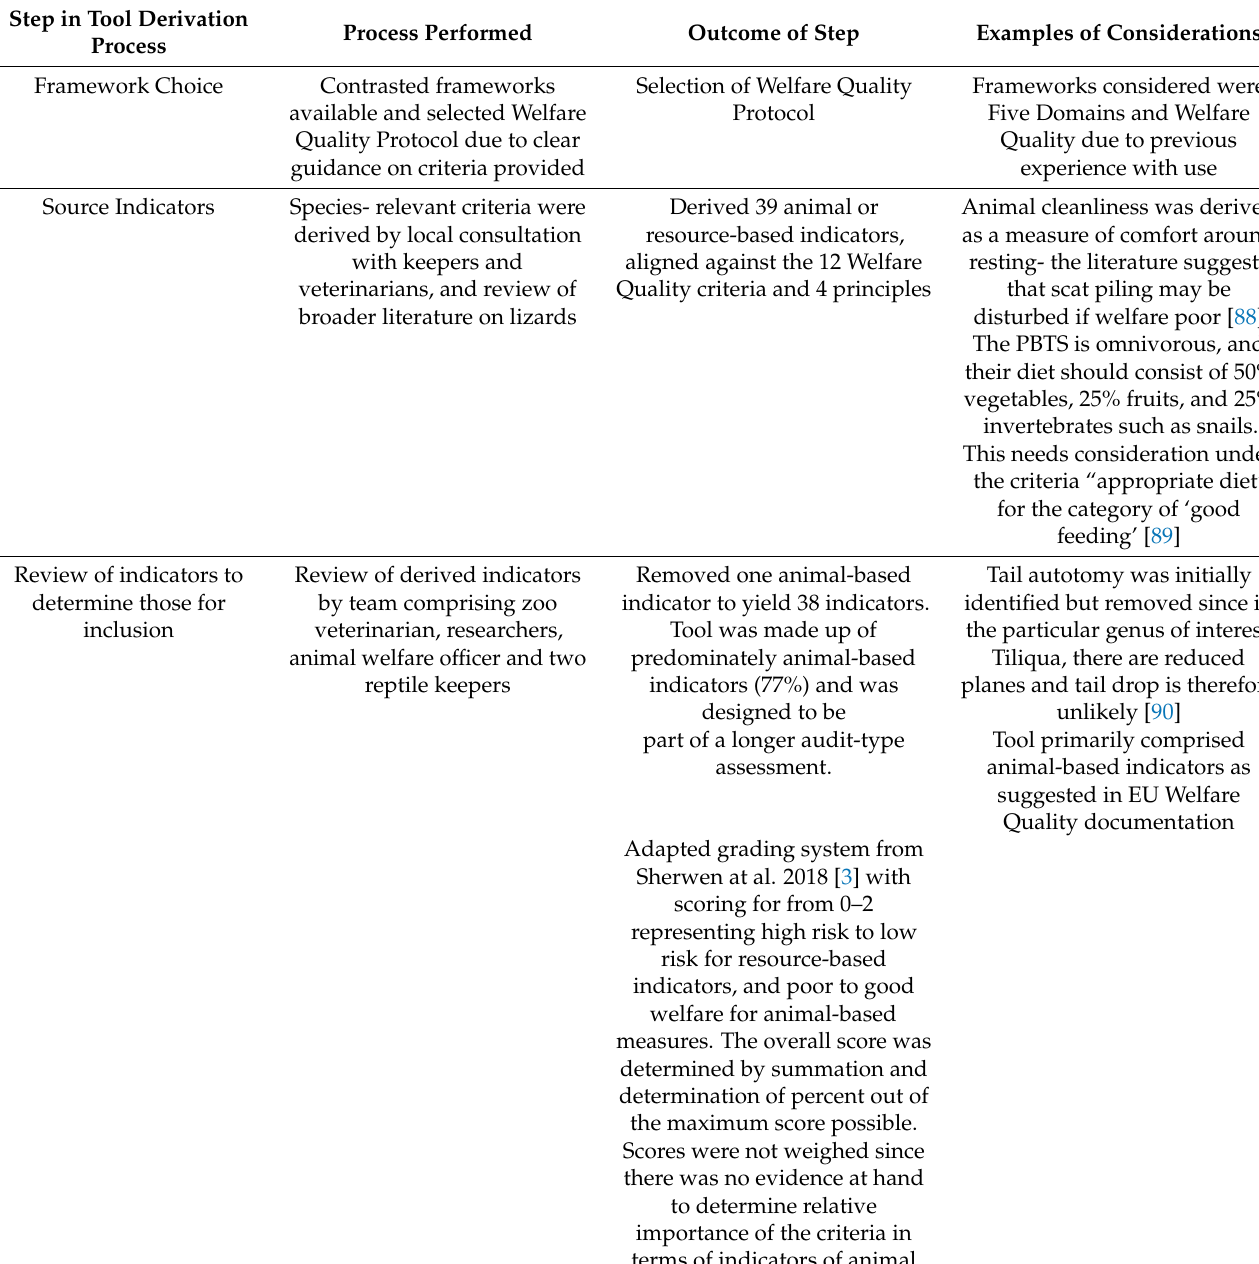
Table 2. Illustrated example of the assessment tool derivation process based on a case study with the pygmy blue-tongue skink (PBTS) ( Tiliqua adelaidensis ) (adapted from [10] under a Creative Commons Attribution CC BY 4.0